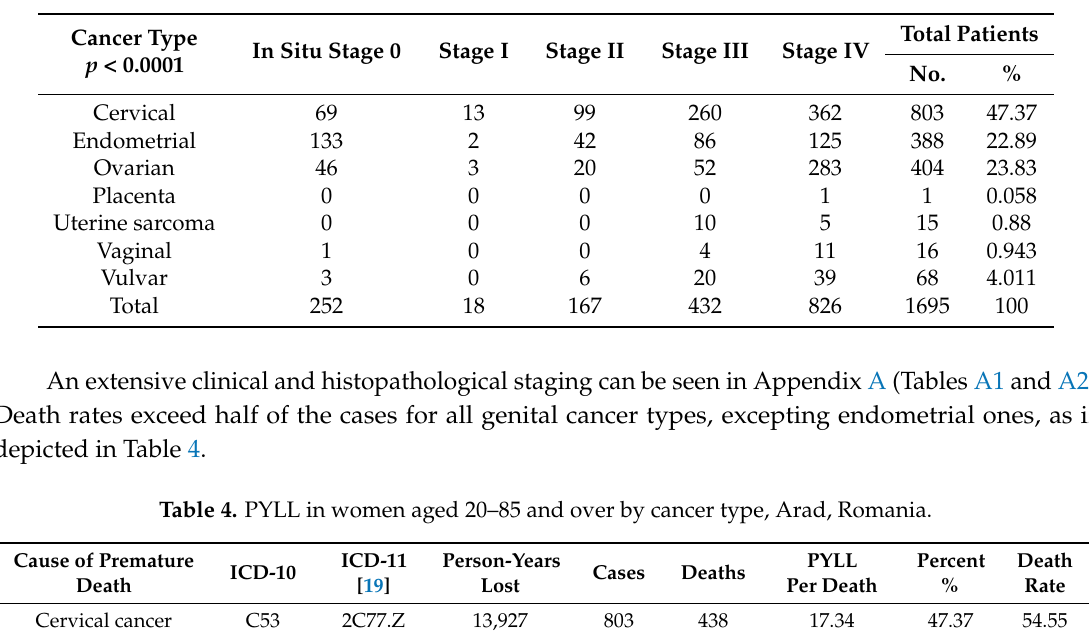
Table 3. Stages in cases with genital cancer.